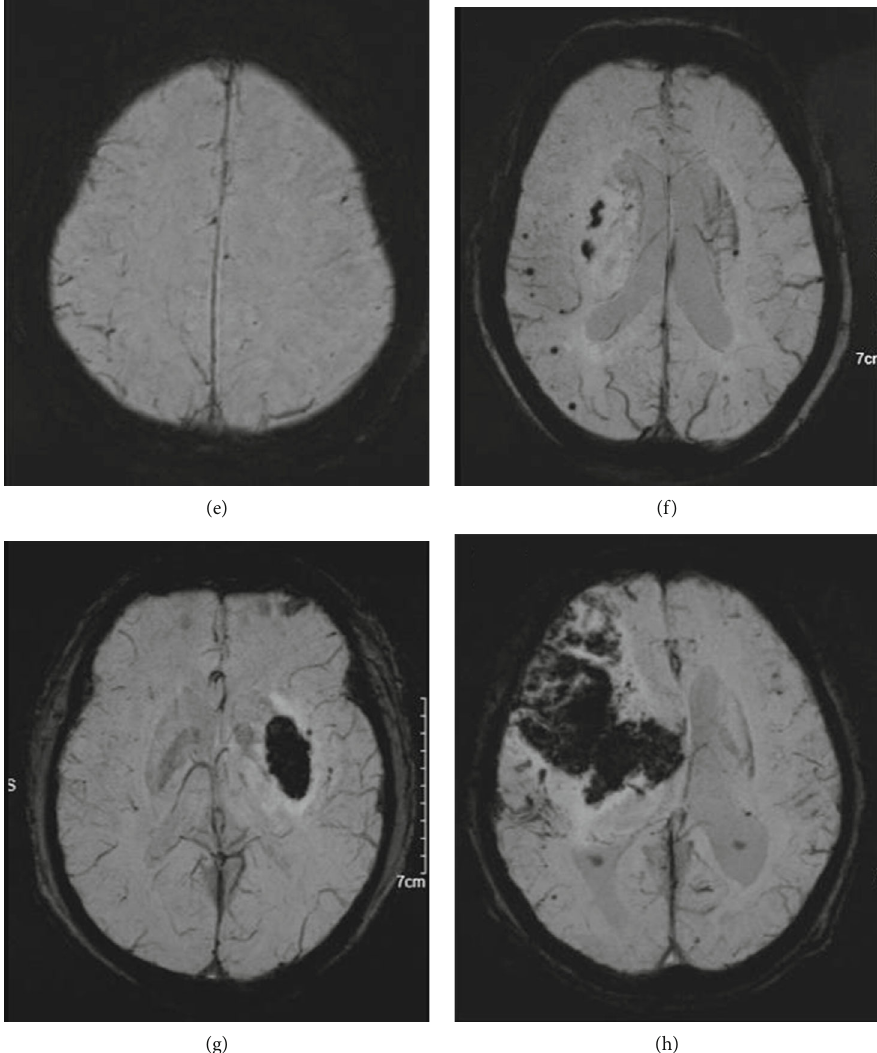
Figure 2: The upper row of images (a – d) show the four types of PCHD, and the lower row of images (e – h) show the prognosis of TH in the corresponding four patients. PCHD-1 showing small area of hyperdensity (the white arrow) without space-occupying e ff ects (a), no TH in follow-up SWI image (e). PCHD-2 showing more con fl uent hyperdensity at the right basal ganglia without space-occupying e ff ects (b), HI-1 was observed during follow-up (f). PCHD-3 showing hyperdensity at the right basal ganglia accompany the ipsilateral narrow sulci (c), pH-1 was observed during follow-up (g). PCHD-4 showing hyperdensity with a signi fi cant space-occupying e ff ect (d), pH-2 was observed during follow-up